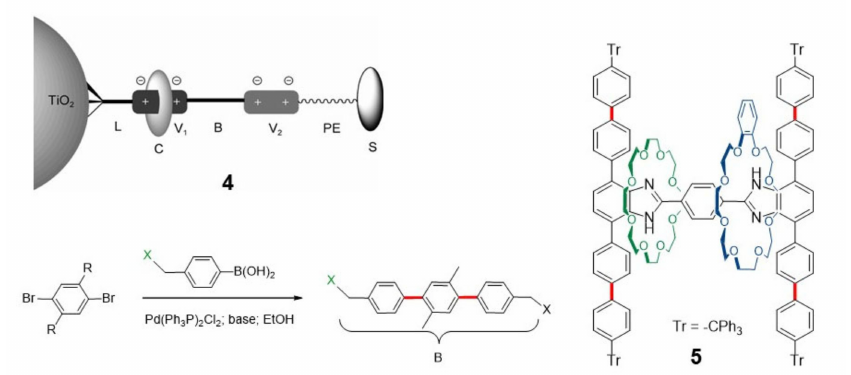
Figure 3. Palladium-catalysed formation of C–C bonds in the tripodal rigid non-degenerate shuttle, 4 [7,8], and the rigid ring-in-ring shuttle, 5 [9].